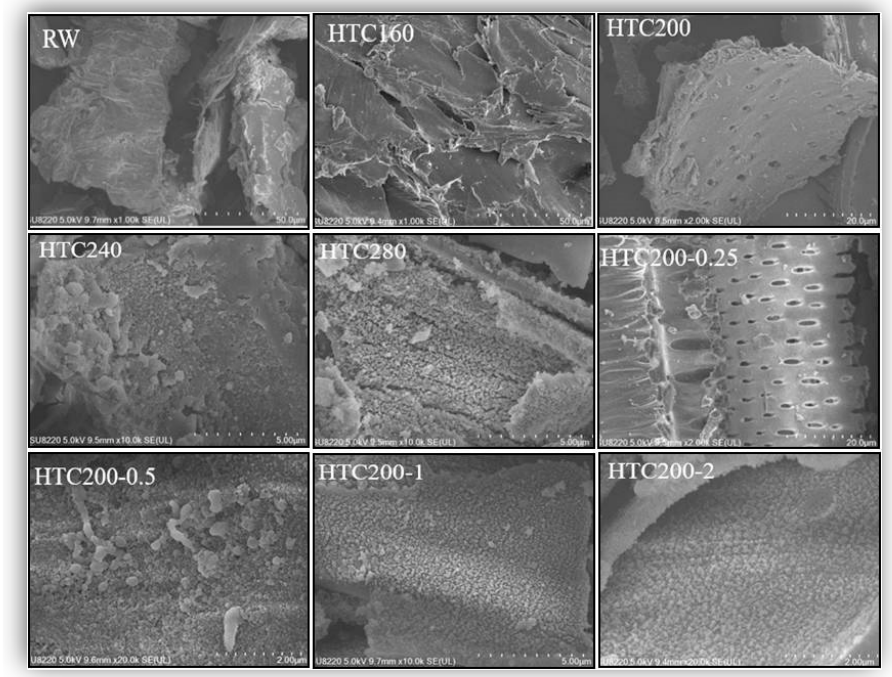
Figure 7. The SEM of hydrochar prepared from different conditions.